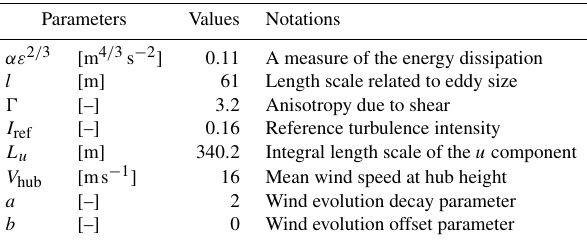
Table 1. The wind field parameters for the validation. αε 2 / 3 , l , and (cid:48) are the Mann model parameters. I ref and L u are parameters of the IEC Kaimal model (turbulence class A). And the rest are the common parameters of both models. The hub height is considered